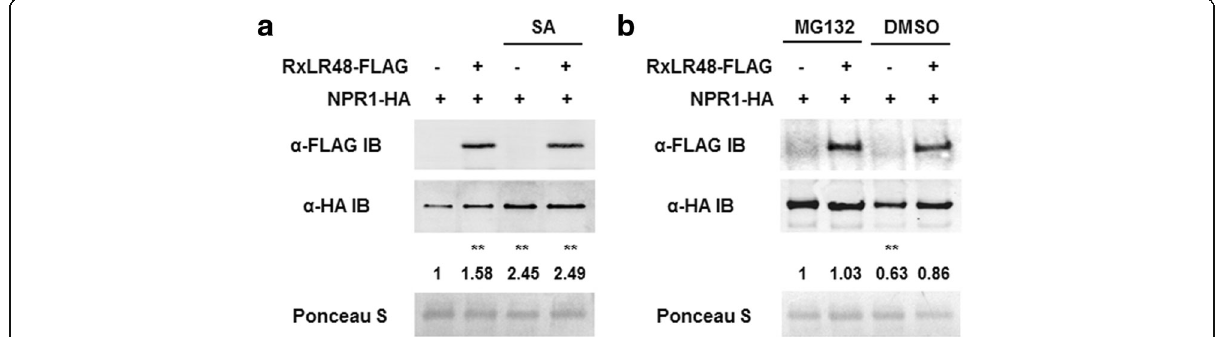
Fig. 5 RxLR48 inhibits protein degradation of NPR1. a Stabilization of NPR1 by RxLR48 in vivo. RxLR48-FLAG and NPR1-HA were transiently co- expressed in Arabidopsis , and protein levels were analyzed by immunoblots with indicated antibodies. Protoplasts were treated with 0.25 mM SA before incubation. Numbers below the blots represent relative abundances of NPR1 and solo expression of NPR1 is set to 1 as the reference. Asterisks indicate significant differences (**, P < 0.01 compared with the reference, Dunnett ’ s test). Ponceau staining was used to show equal loading. b Increased accumulation of NPR1 by RxLR48 or MG132. Protoplasts were transiently transfected with the indicated constructs, followed by DMSO or MG132 (100 μ M) treatment before incubation overnight. Protein levels were analyzed and relative abundances of NPR1 were calculated as described above. Asterisks indicate significant differences (**, P < 0.01 compared with the reference, Dunnett ’ s